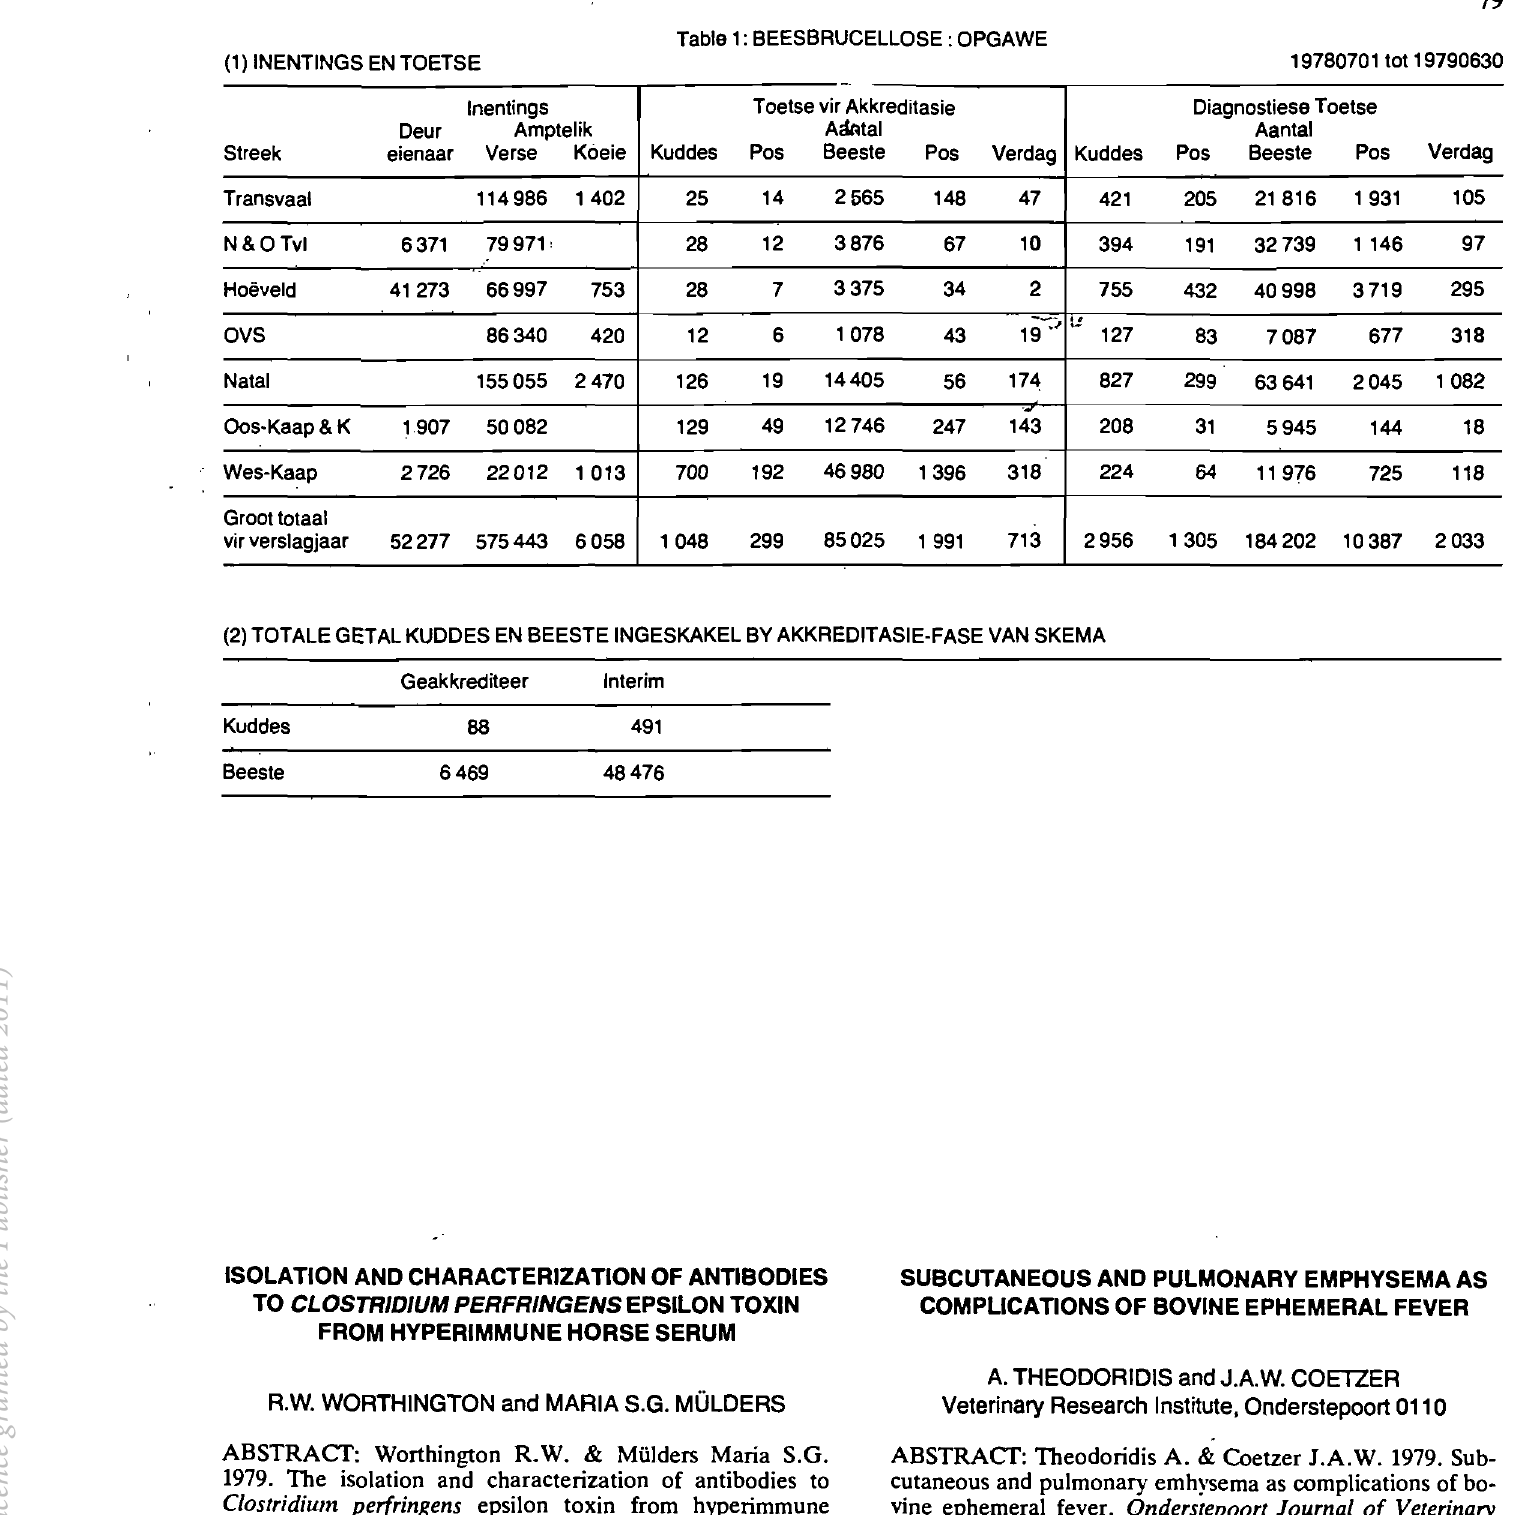
Table 1: BEESBRUCEllOSE : OPGAWE (1) INENTINGS EN TOETSE 19780701 tot 19790630